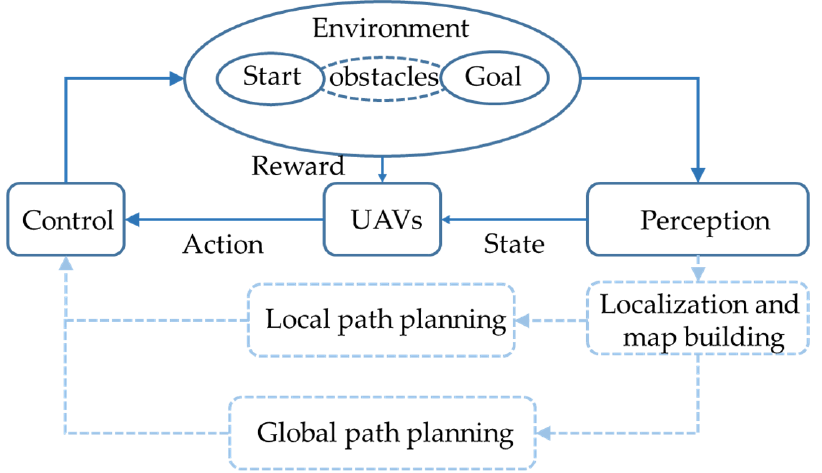
Figure 1. DRL-based navigation system. The solid line part of the picture is the method using reinforcement learning as path planning, and the dotted line is the traditional path planning method.